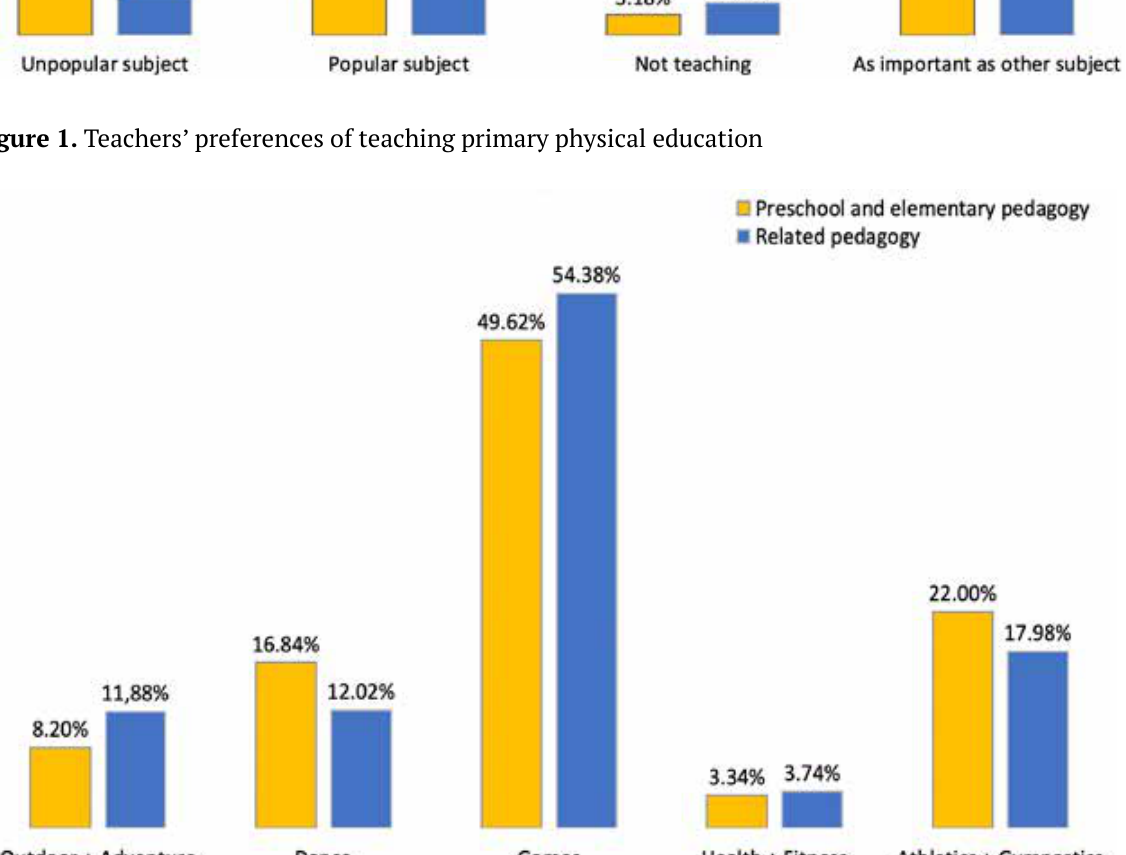
Figure 2. Popular teaching activity in primary physical